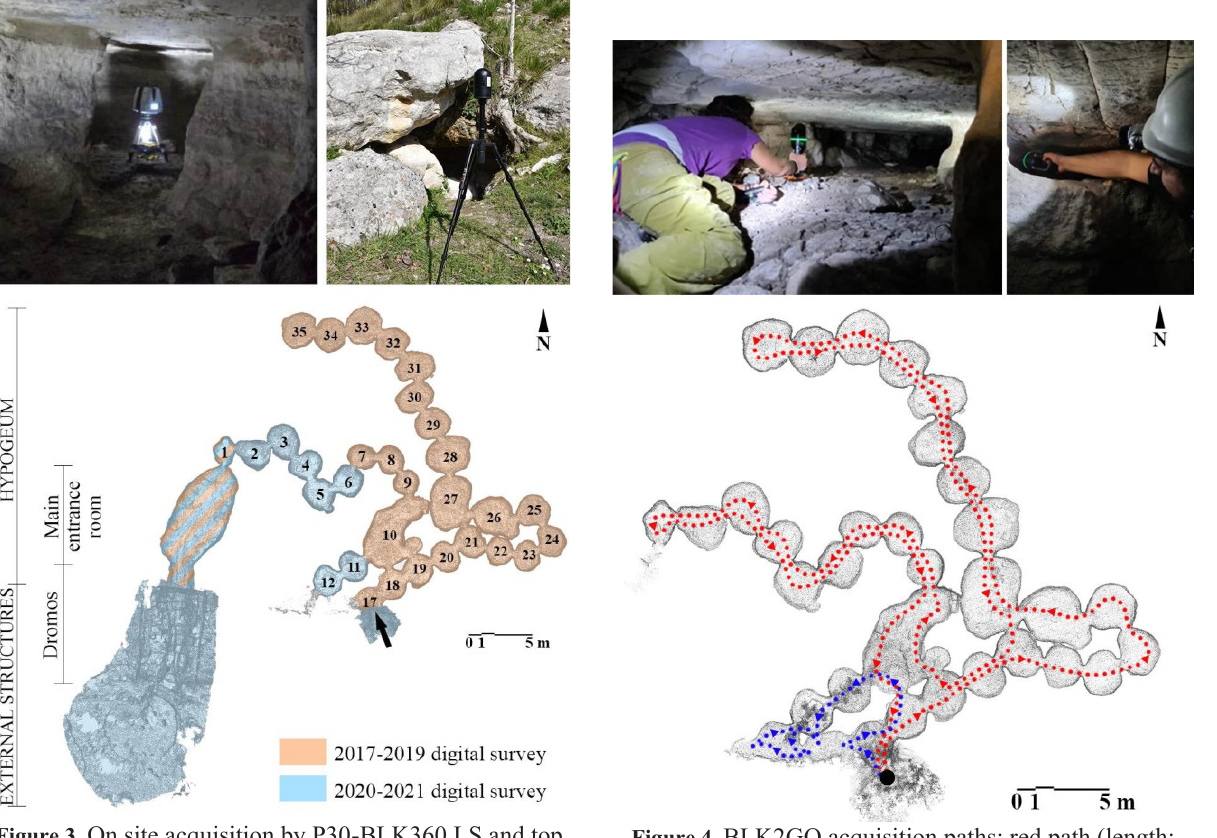
Figure 4 . BLK2GO acquisition paths: red path (length: 147 m., time: approx. 18 min.), blue path (length: 25, time: approx. 6